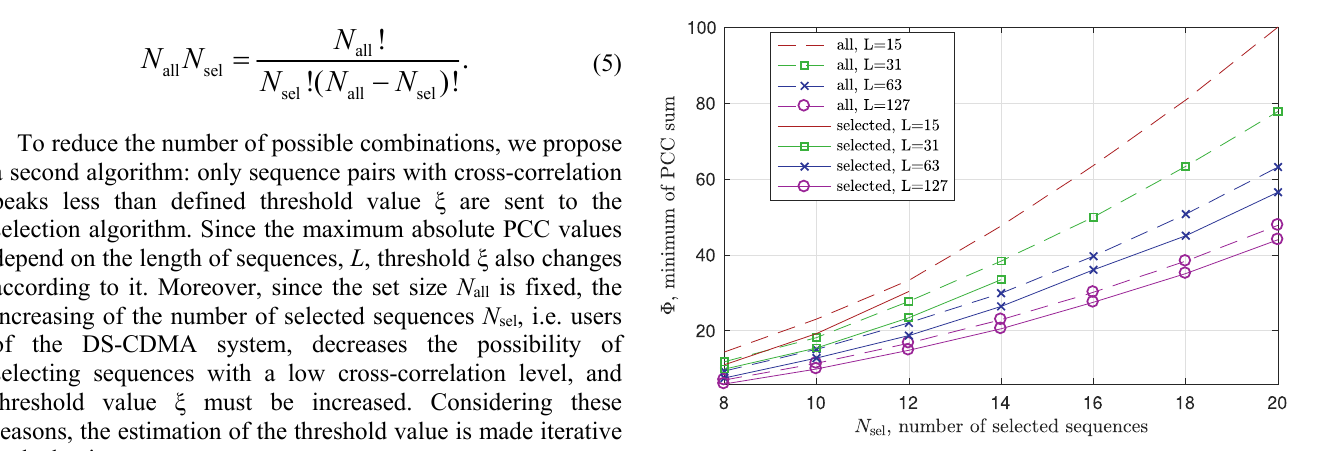
Fig. 4. Dependence of PCC peak sum on the number of selected or all generated chaotic